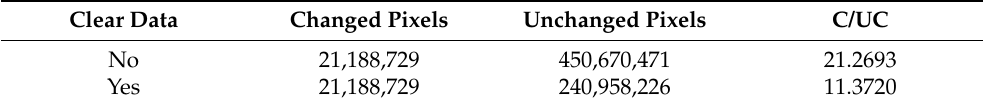
Table 1. Statistics of changed pixels and unchanged pixels before and after cleaning data.